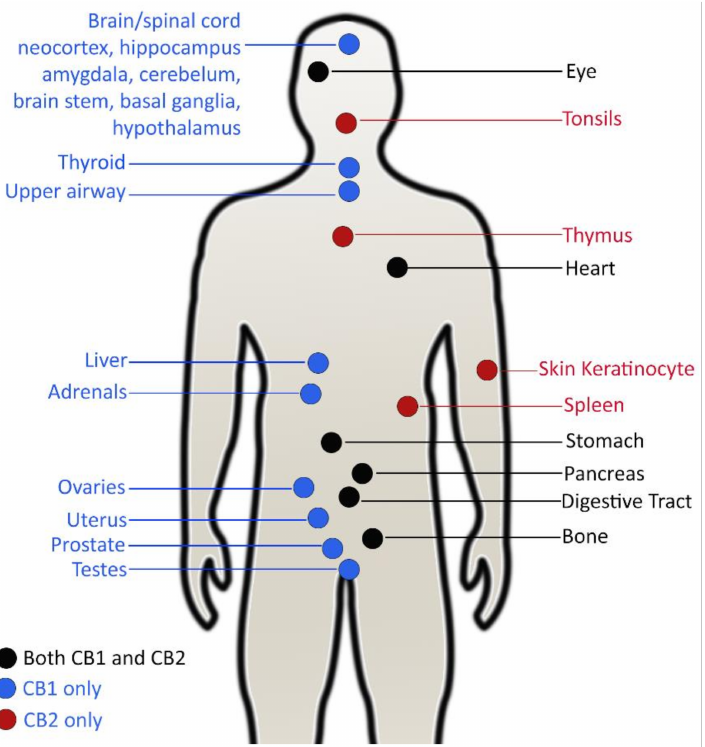
Figure 2. Location and distribution of main cannabinoids receptors in the human body (adapted from